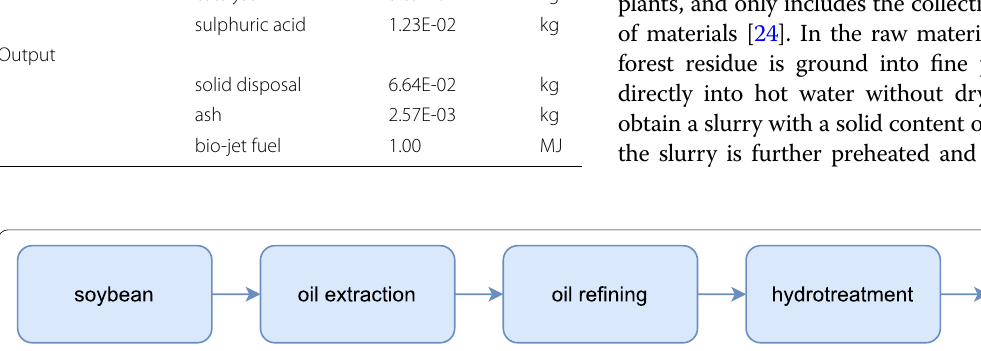
Fig. 3 Production process of HEFA technical